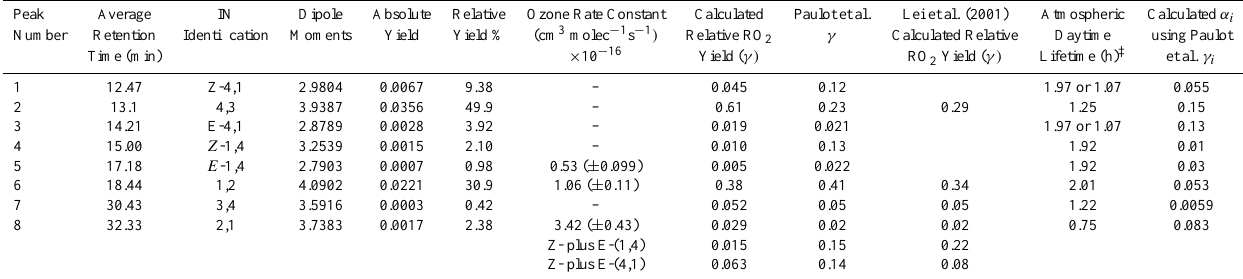
Table 1. Isoprene nitrate data. The peak numbers represent the peaks labeled in Fig. 5 and in the IN identification in the Results and Discussion section. ‡ The (4,1)-IN isomers have 2 values for their lifetime. The lower value represents the lifetime using the average ozone rate constant (1.67 × 10 − 16 cm 3 molecule − 1 s − 1 ) . The higher value represents the lifetime if we assume that the (4,1)-IN isomers have a similar ozone rate constant to the